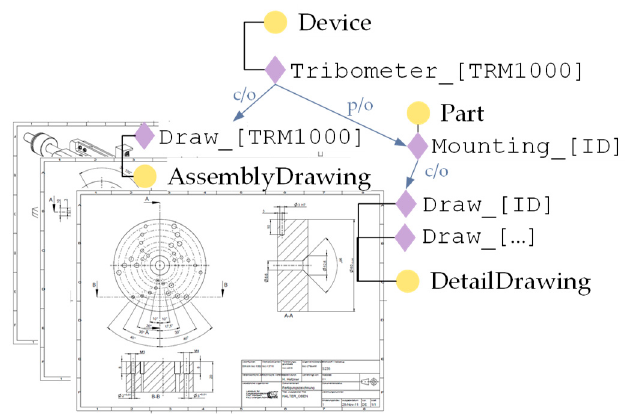
Figure 13. Linking CAD data to a device.